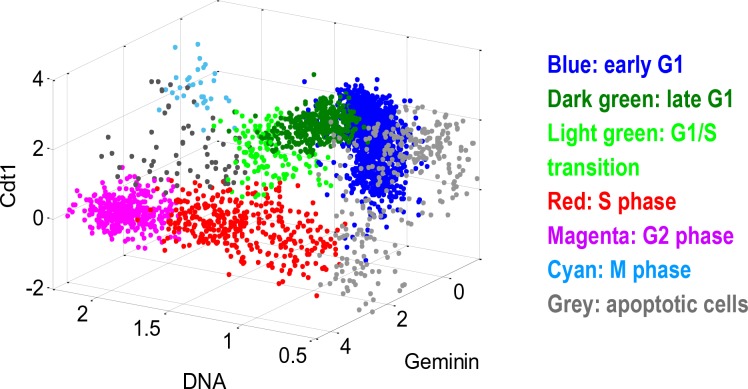
Cells from each well were partitioned, according to the three cell cycle indicators (DNA, Geminin, Cdt1), into discrete cell cycle stages.The scatterplot illustrates a control well (DMSO treated). Each point in the scatterplot is an individual cell. The DNA axis is normalized (1 = 2N, 2 = 4N). The Geminin and Cdt1 axes are in log scale (a.u.).